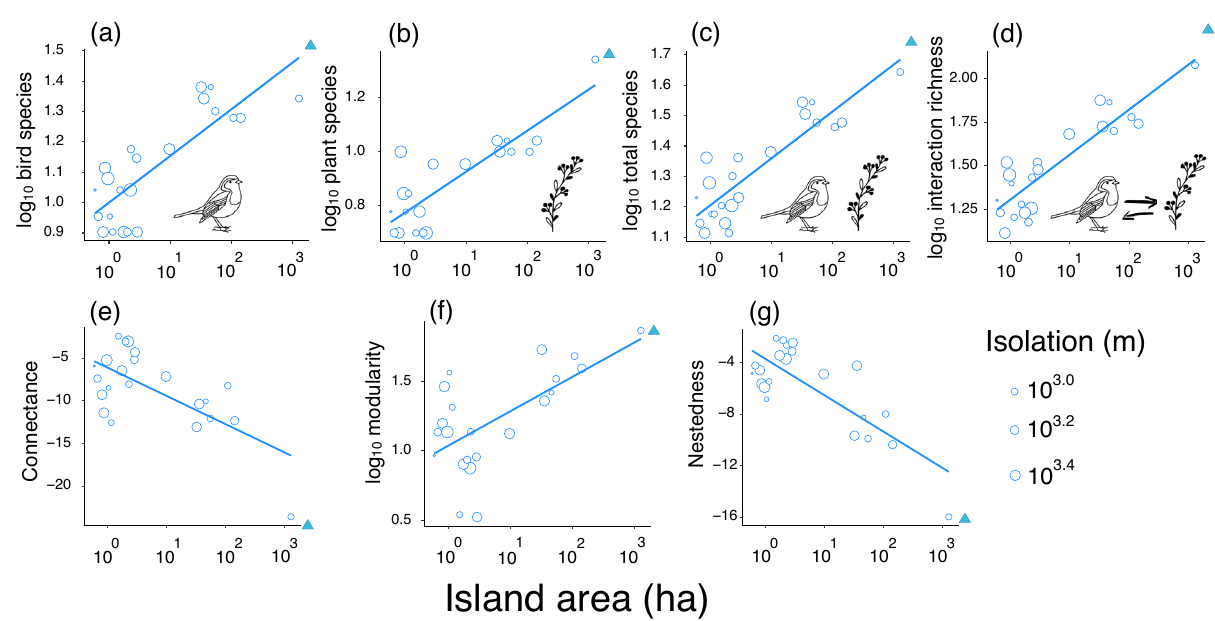
Fig. 3 The effect of island area and isolation on the diversity (species and interaction) and the structures of plant-frugivore networks in the Thousand Island Lake, China. a – d show species and interaction richness increasing with island area. e – g show three whole-network indices (connectance, modularity and nestedness) changing with island area. Each hollow circle corresponds to a reservoir island, and solid triangles indicate data from the surrounding mainland sites. The lines show the predicted values of diversity and network structural metrics for island areas obtained by holding isolation constant at their means. A greater circle indicates islands with higher isolation. Besides nestedness and connectance, all variables were log 10 -transformed. Note that network metrics (i.e., connectance, modularity and nestedness) were standardised to z -scores using null models.